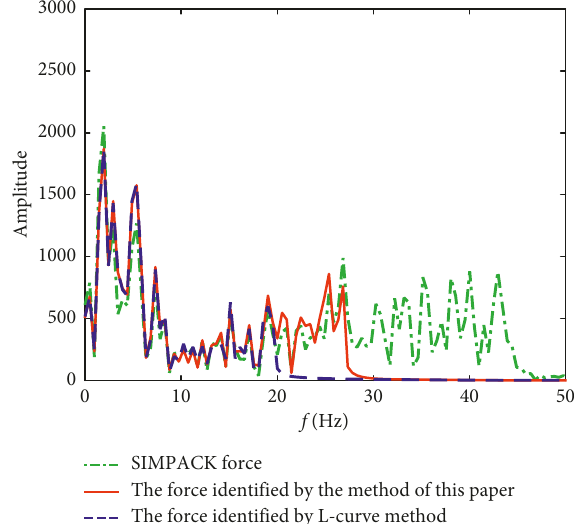
Figure 24: Amplitude-frequency curve of the two methods for F identification when the noise level is 4